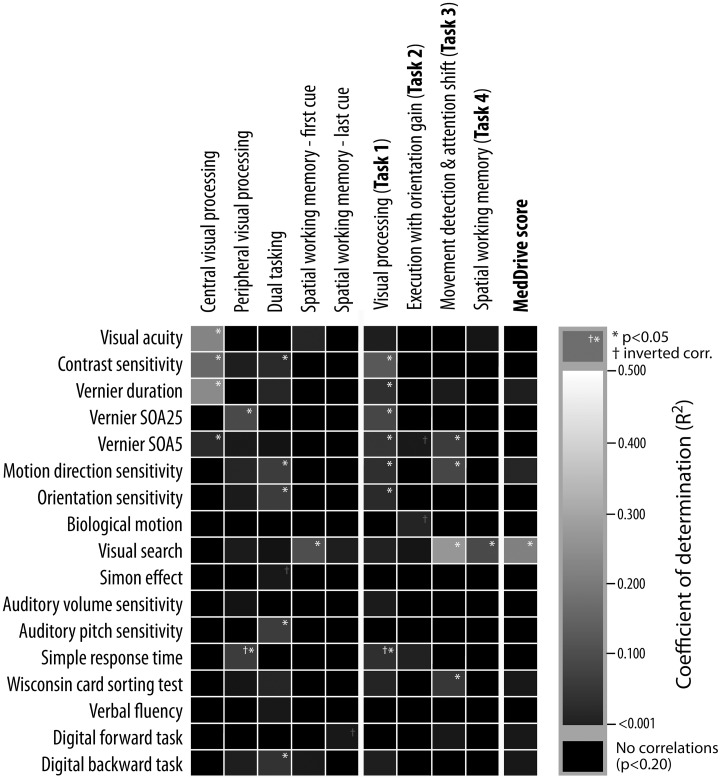
Underlying psychophysical properties of MedDrive outputs. Columns represent outputs from MedDrive, whereas rows represent results from psychophysical and neuropsychological tests. The lighter the square, the stronger is the correlation between the two. White stars correspond to a significant level of p < 0.05 unadjusted for multiple testing. Visual processing score was significantly associated to all visual processing measures except for biological motion detection. The output from the movement detection task (Task 3) was associated to visual processing, visual search, and to mental flexibility (WCST). Interestingly enough, when all these measures were combined in a single score (MedDrive score) this score was then highly correlated to visual search. This leads us to believe that the MedDrive score is a good indicator of a person's ability to detect and interpret peripheral visual stimuli. SOA, stimuli onset asynchrony; R2, coefficient of determination; WCST, Wisconsin card-sorting test.